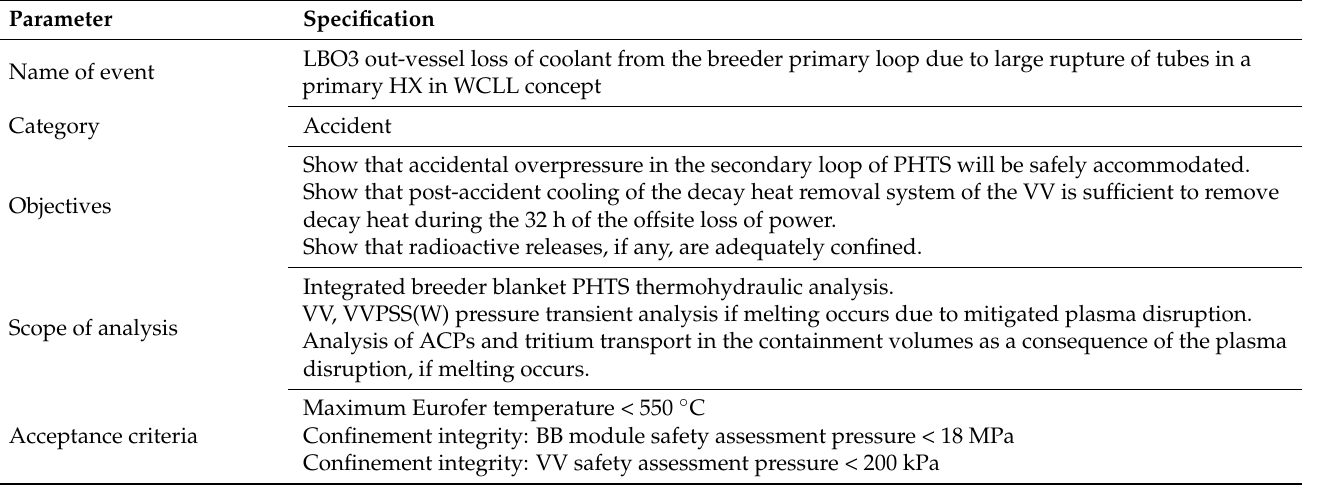
Table 7. Accidental scenario general specifications.